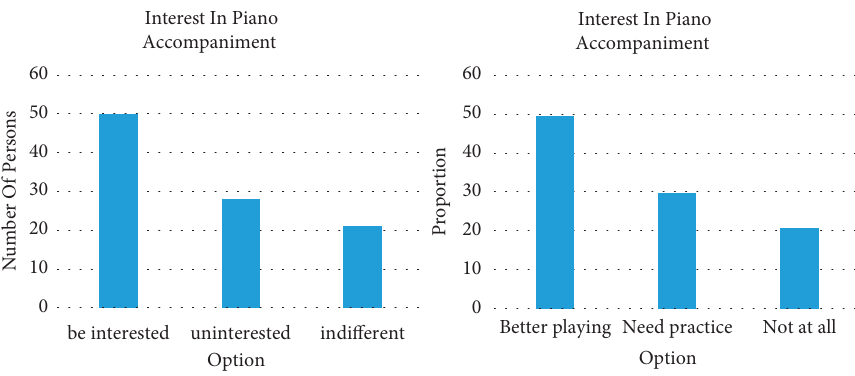
Figure 7: Students’ interest in piano improvisation